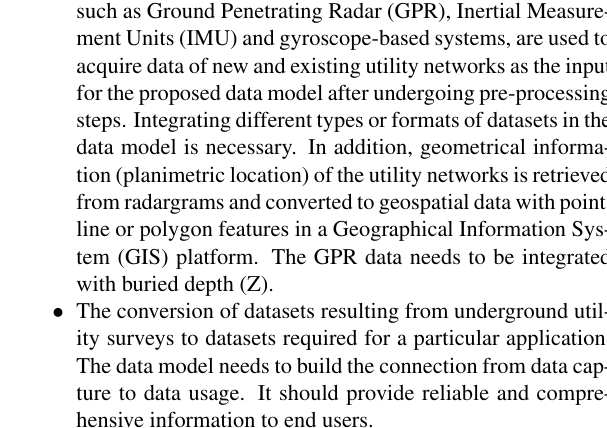
Figure 2. An example of utility data in Singapore (Source: Singapore Land Authority, 2018).